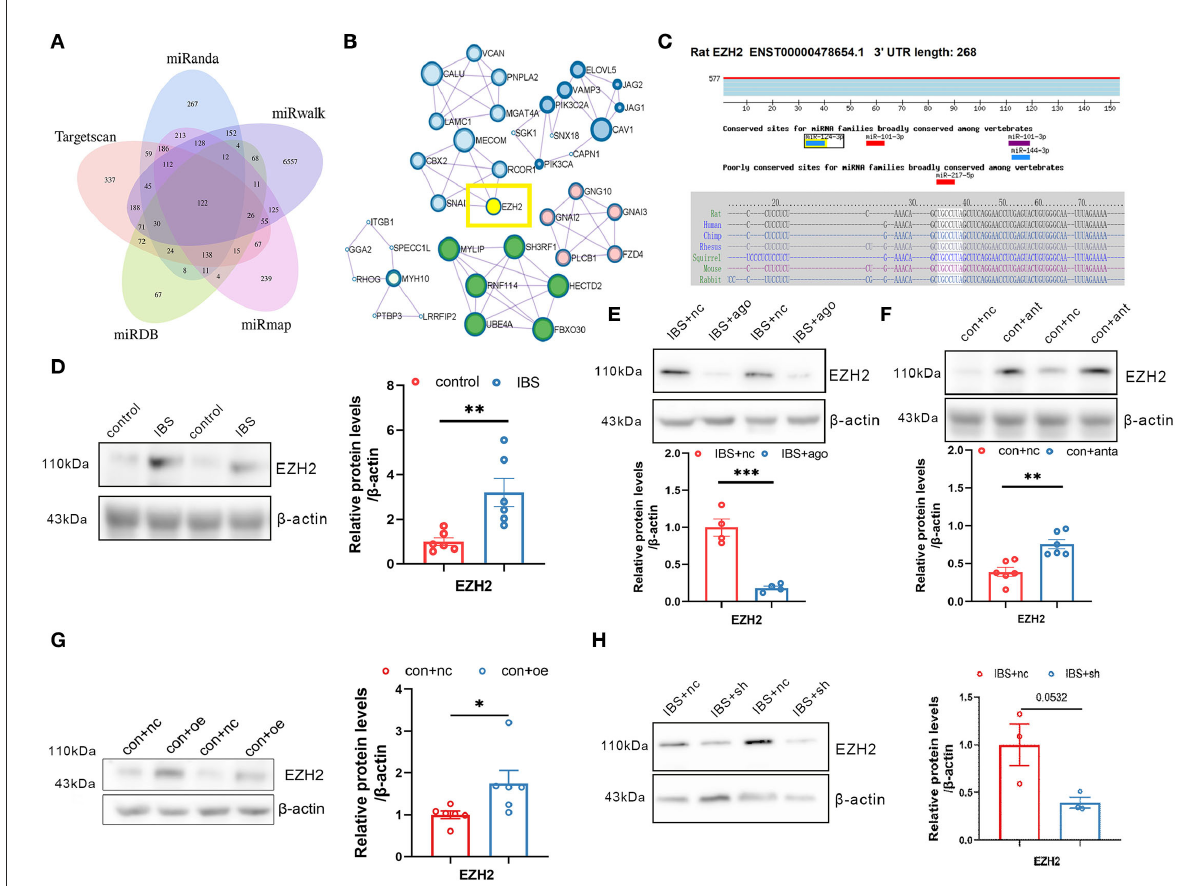
FIGURE6 Hippocampal EZH2 is regulated by circKcnk9 and miR-124-3p. (A) Interactions between miR-124-3p and its target genes were predicted using Target Scan, miRDB, miRwalk, miRmap and miRanda databases. (B) MCODE in Cytoscape candidate target gene PPI network. (C) Sequence conservation of EZH2 binding site for miR-124-3p. (D) Representative images (left) and quantification (right) of the EZH2 protein expression in hippocampus of control and IBS-like rats. N = 6, ** p < 0.01. Western blot quantification of EZH2 after CA1 treatment of agomiR-124-3p in IBS-like rats ( E ; N = 4) and antagomir in controls ( F; N = 6). ** p < 0.01, *** p < 0.001. Western blot quantification of EZH2 after CA1 treatment of aav-circKcnk9 in control ( G; N = 6) and shcircKcnk9 in IBS-like rats ( H; N = 3). * p < 0.05. MCODE, MCODE network clustering analysis; PPI, protein-protein